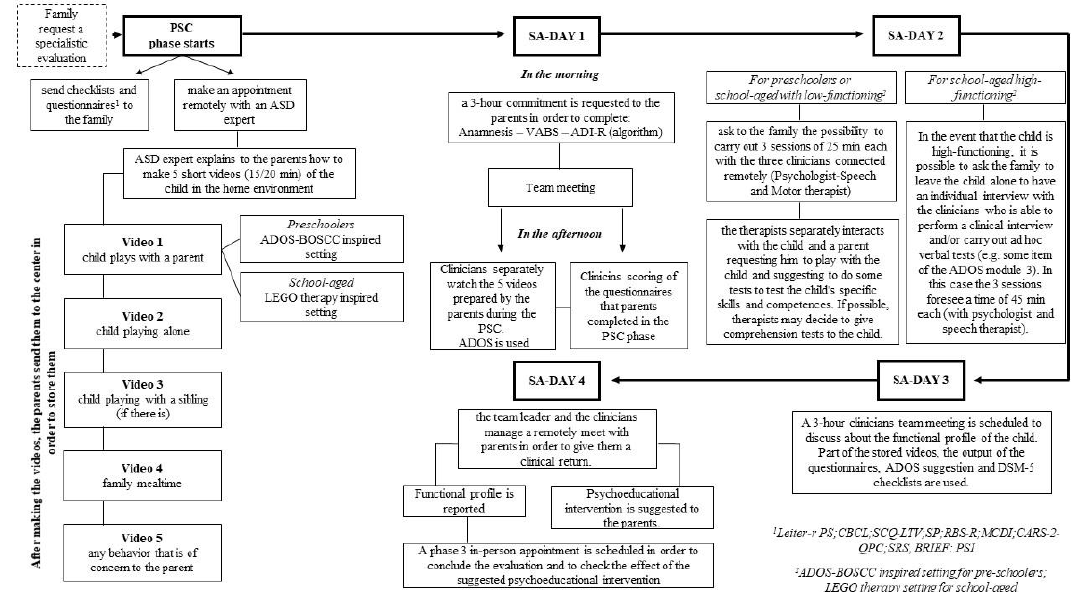
Figure 1. Working model for (preliminary) diagnosis. PSC: pre-specialistic consultation; SA: specialistic assessment; ASD: Autism Spectrum Disorder; ADOS-BOSCC: Autism Diagnostic Observation Schedule-Brief Observation of Social Communication Change; VABS: Vineland Adaptive Behaviour Scales; ADI-R: Autism Diagnostic Interview-Revised; DSM-5: Diagnostic and Statistical Manual of Mental